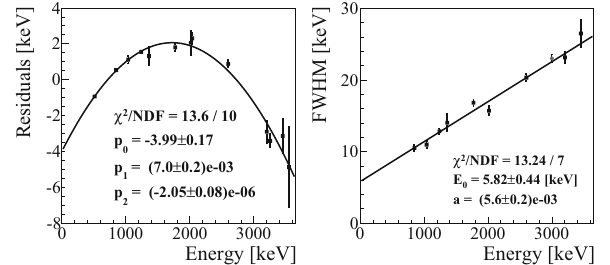
Fig. 5 Study of the most prominent γ peaks of 56 Co, calibrated with the coefficients derived from the 232 Th calibration. Left: difference between the nominal energy and the peak position as a function of the energy. Data are fitted with a parabolic function, resulting in 1.3keV residual at the 82 Se Q-value. Right: FWHM energy resolution as a func- tion of the energy (black squares). Data are fitted with a linear function (cid:4) E = E + aE . The red circle indicates the value extrapolated from 0 the 232 Th calibration in Ref.